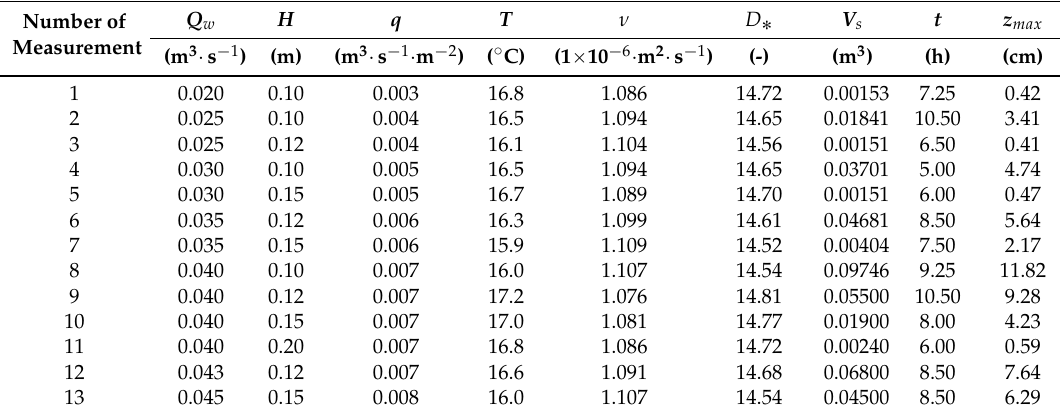
Table 1. Summary of the test’s main